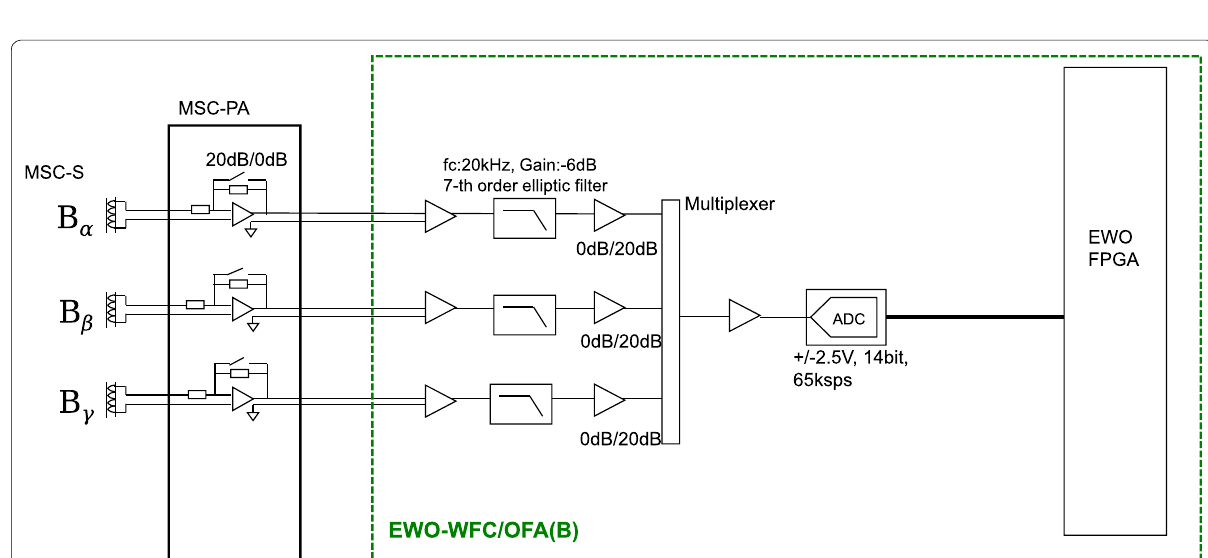
Fig. 9 Simplified block diagram of the MSC and EWO-WFC/OFA(B). Detailed specifications and performance of the MSC and EWO-WFC/OFA(B) are presented in Ozaki et al.